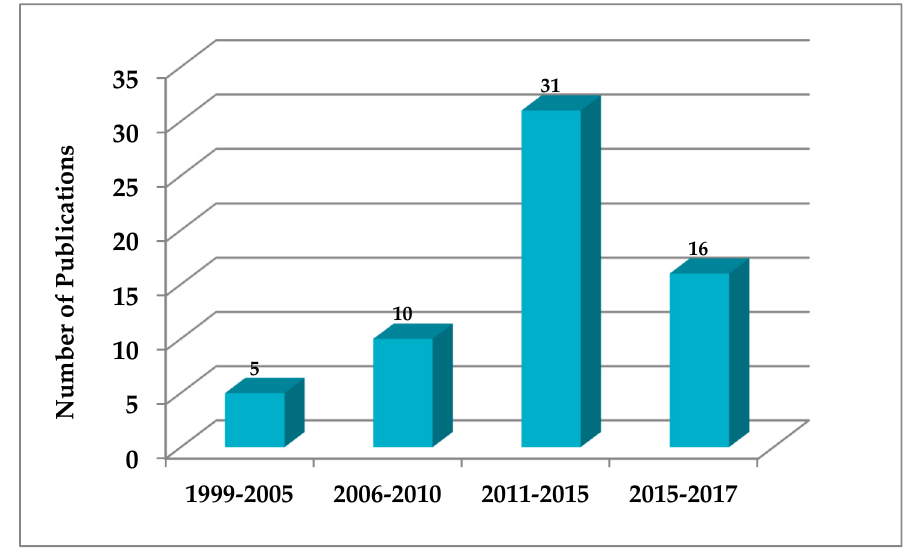
Figure 4. Number of Articles Selected from SCLRA and SLR according to Year.